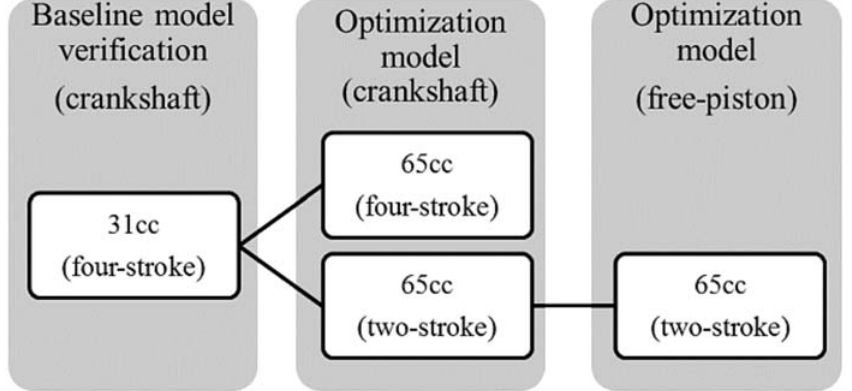
Figure 3. Types of models developed for the research.